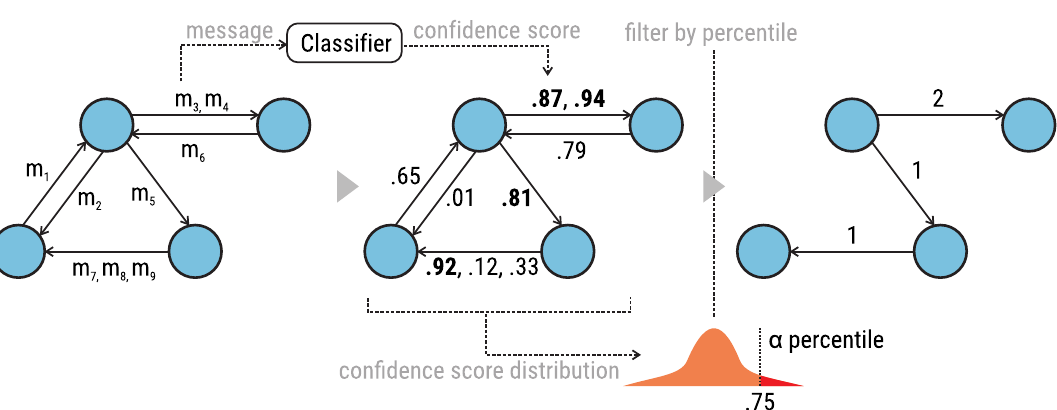
Figure 4. Example of how a dimension-specific conversation multigraph G d is built. First, the text classifier for dimension d is applied to all messages and outputs scores that are proportional to the likelihood of a message containing dimension d . Then, for each dimension individually, a score threshold is determined based on a selected percentile α in the overall score distribution. In the illustrated example, the value corresponding to the α percentile is 0.75. Last, only the edges with the messages that pass that threshold are kept; the messages are counted to compute the edge